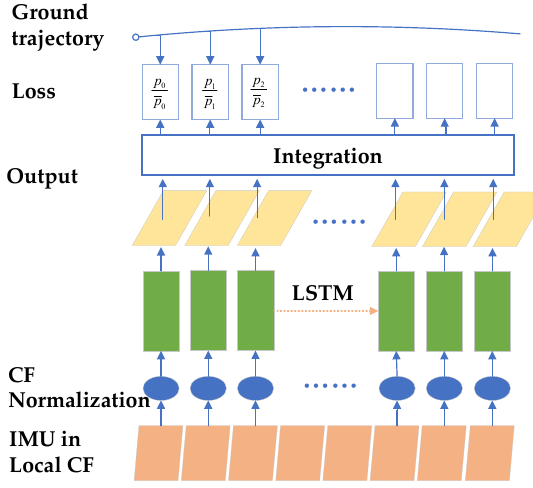
Figure 5. LSTM architecture diagram.